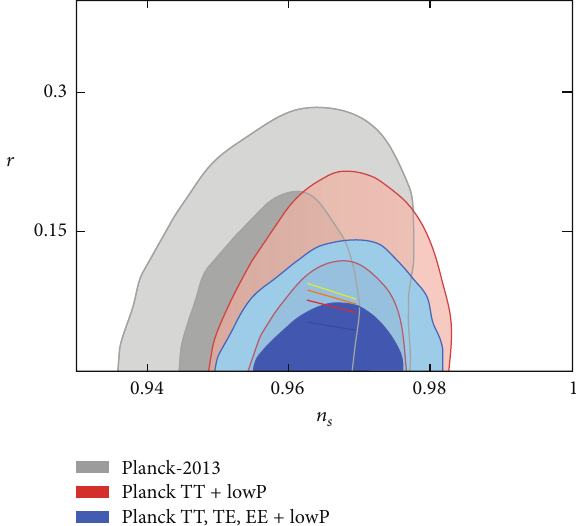
Figure 2: The figure shows the tensor-to-scalar ratio versus the scalar spectra